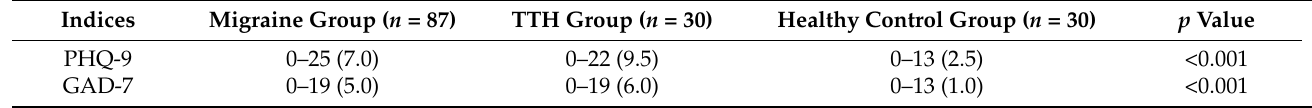
Table 5. Scores of psychological symptoms in the migraine, TTH, and healthy control groups.